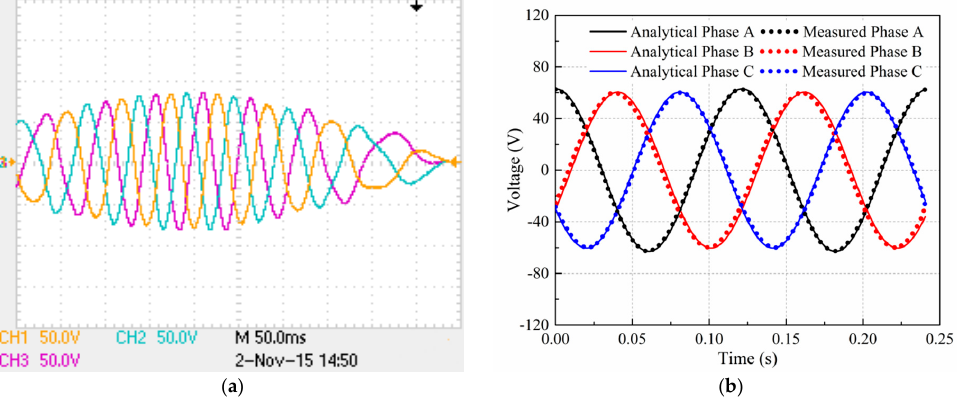
Figure 18. ( a ) Measured back EMF of the linear motion unit at the average speed of 0.68 m/s; and ( b ) comparison of the analytical and measured back EMF of the linear motion unit at 0.33 m/s. The comparison of the back EMF and time for analytical calculation and FEM is shown in Table 2.